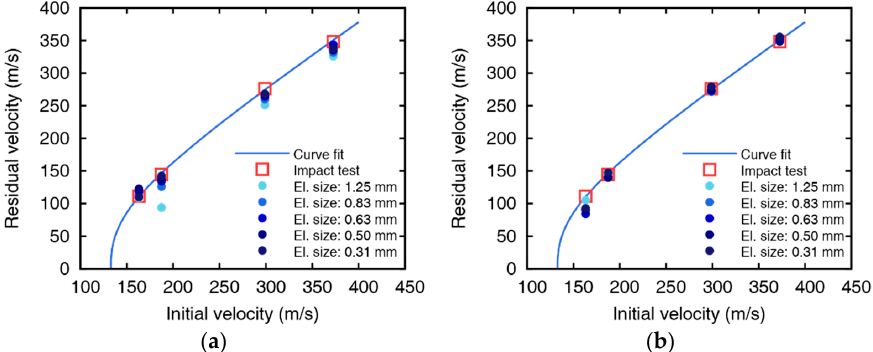
Figure 12. Initial and residual velocities of ( a ) Johnson-Cook damage model and ( b ) EDFS with the curve fit from the impact tests of 5 mm aluminum plates.